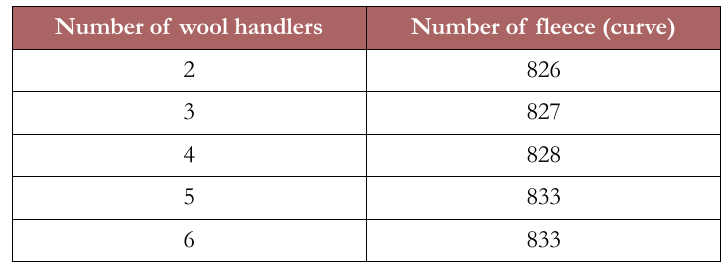
Table 4. the second scenario adding extra wool